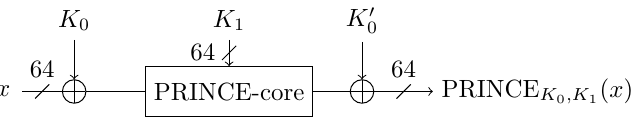
= ( K 0 ≫ 1) ⊕ ( K 0 (cid:29) 0